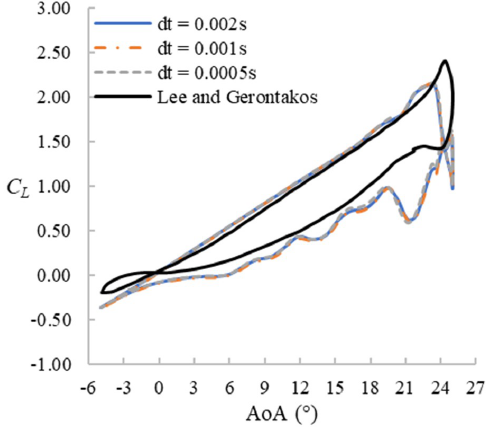
Figure 4. Lift hysteresis loop for different mesh resolutions (2D, Δt = 0.001s).